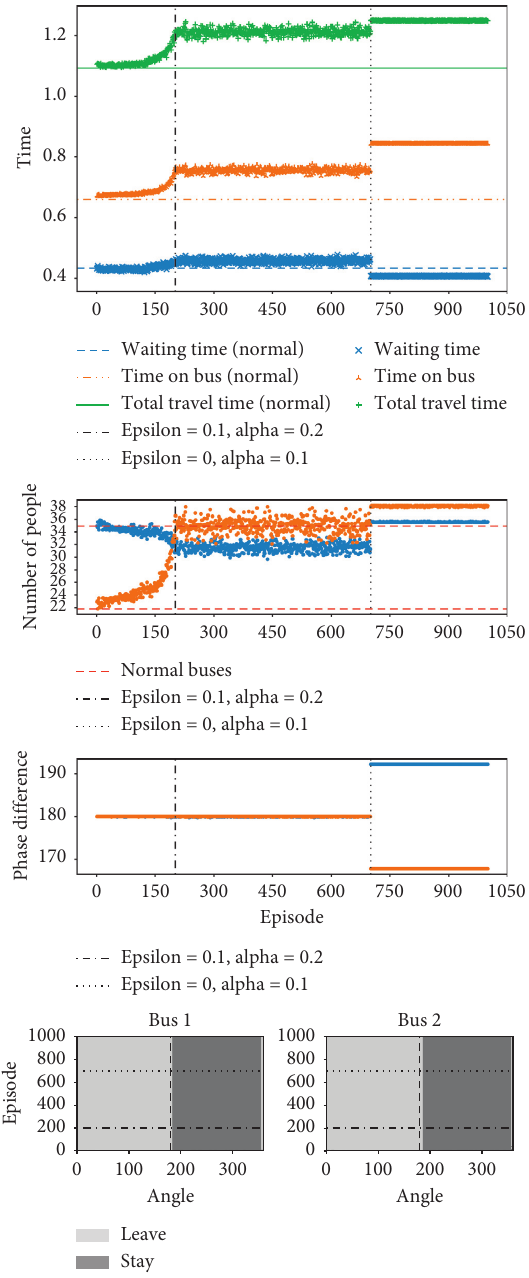
Figure 8: Two buses with frequency detuning serving a loop of bus stops during a lull period learn the holding strategy by rein- forcement learning. It is able to slightly improve the average waiting time, at the expense of slowing down the fast bus such that the average time spent on bus and average total travel time are increased.